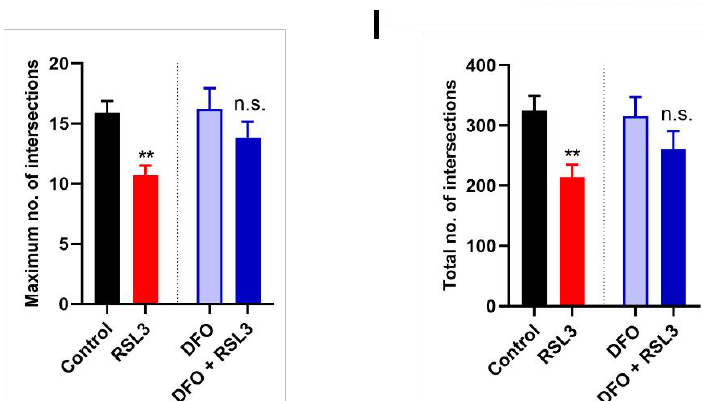
Figure 3. Ferroptosis induces cell swelling and reduces dendritic complexity in primary hippocampal cultures. ( A ). Representative light microscopy images showing a control neuron treated with DMSO (control) and a neuron treated with RSL3, displaying cell swelling and dendritic damage (indicated by red arrows). Scale bar 100 µm (left) and 50 µm (right). ( B ). Representative confocal microscopy images of primary hippocampal cultures treated with DMSO (control) or RSL3 and labeled with MAP2A antibody. Scale bar 10 µ M. ( C , D ). Quantification of soma perimeter and area showing the mean of each independent hippocampal culture. Statistically significant differences among experimental conditions were evaluated using a paired t-test. ( E ). Quantification of soma perimeter and area of individual cells; N = 3 independent hippocampal cultures. ( F ). Representative images of hippocampal neurons transfected with RFP for morphological analyses. Scale Bar: 50 µ m. ( G ). Sholl Analysis of neurons treated with DMSO (control), DFO, RSL3, or DFO + RSL3. ( H , I ). Quantification of morphological parameters. ( H ). Maximum number of intersections and ( I ). total number of intersections for DMSO (control); n = 23; DFO, n = 24; RSL3, n = 25; DFO + RSL3, n = 31. N = 3 independent